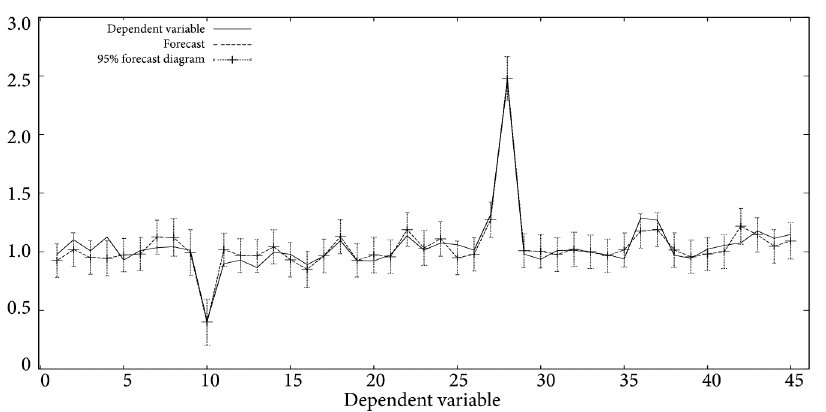
Figure 2. Forecast diagram on the evolution of the dependent variable for the 1 st model (source: GRETL program)